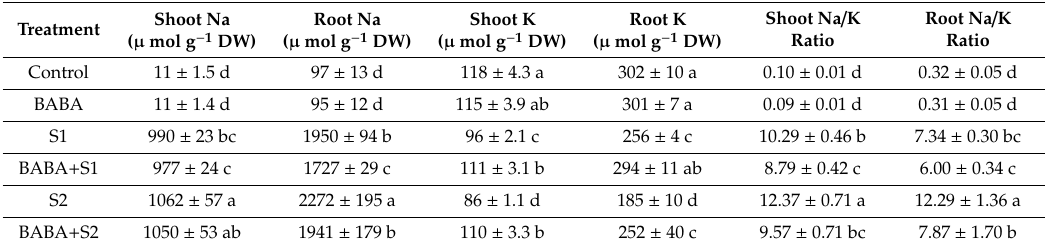
Table 1. E ff ect of β -aminobutyric acid (BABA) on Na content, K content, and the ratio of Na and K in both shoot and root of rapeseed ( Brassica napus L.) seedlings exposed to di ff erent concentrations of salt stress. Average from three replications (n = 3) was used to determine mean ( ± SD) for each treatment and means of the same column were compared by letters, where letters with di ff erent values varied significantly at p ≤ 0.05 due to Fisher’s least standard di ff erence (LSD) test. Treatment